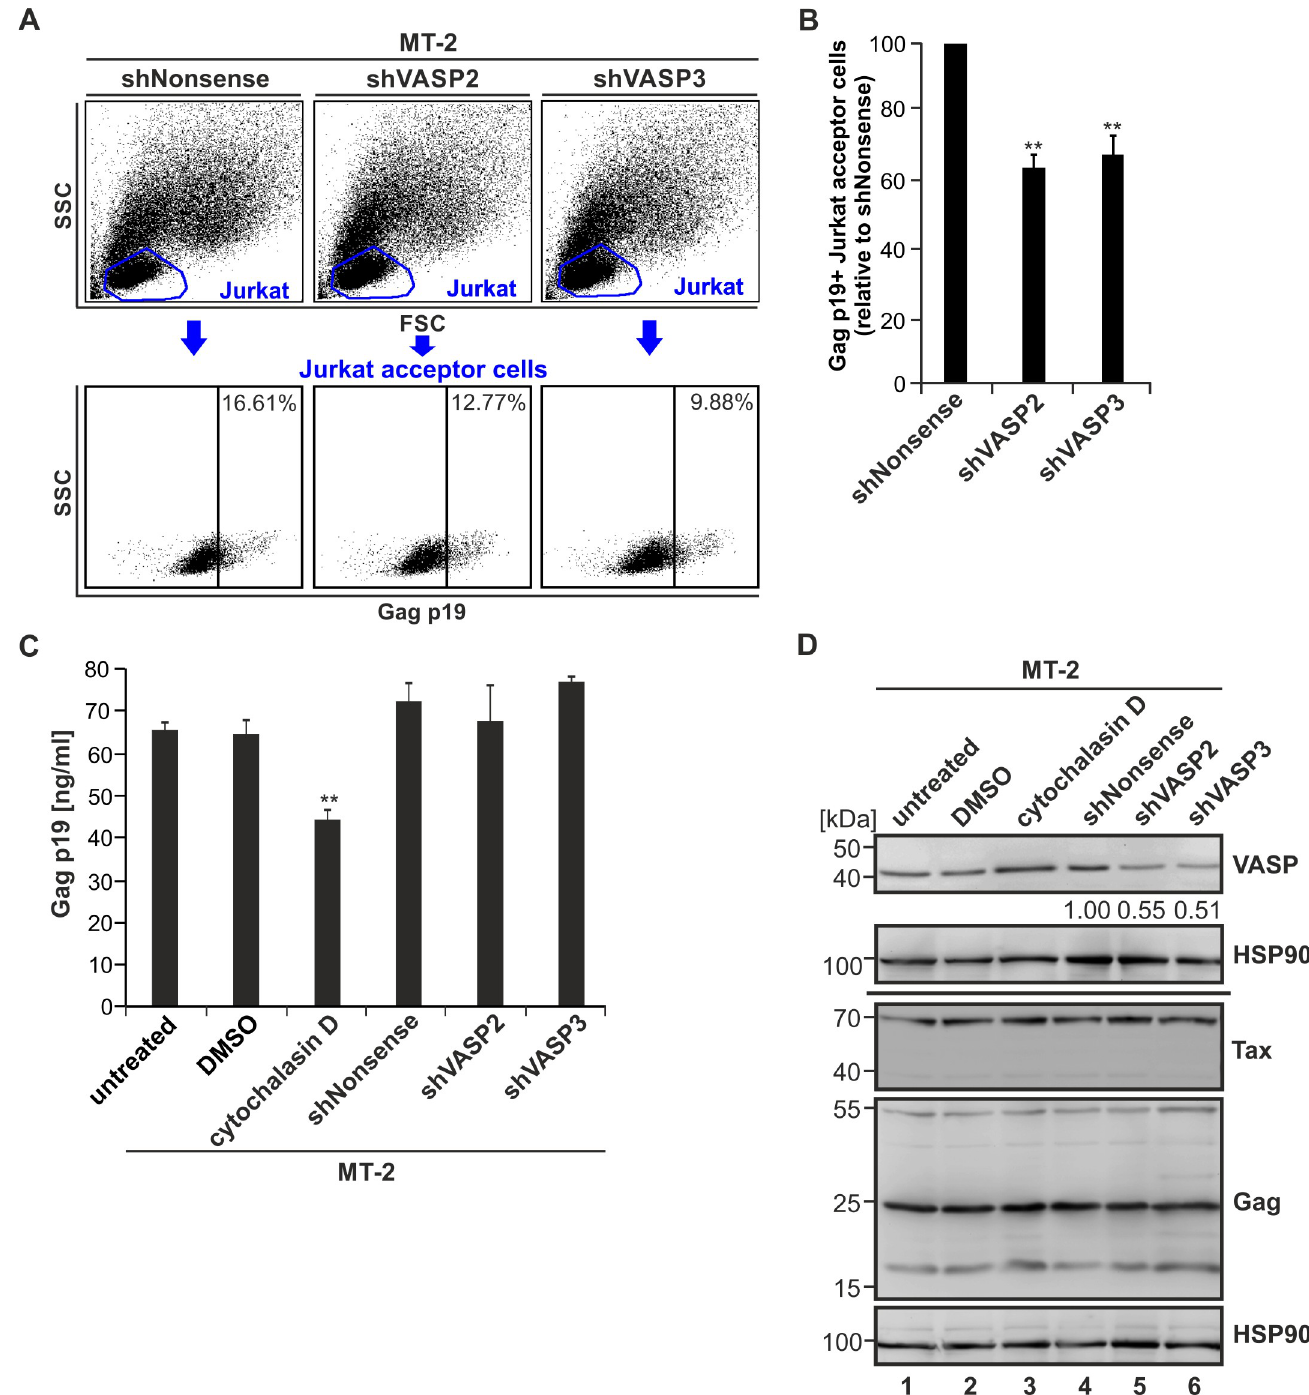
Fig 10. Repression of VASP impairs virus transmission to uninfected T-cells, but not Gag processing and virus release in chronically infected MT-2 cells. (A) Jurkat T-cells were co-cultured with stably transduced MT-2 cells (shNonsense, shVASP2, shVASP3) at a ratio of 1:1 for 1 h. The transfer of Gag p19 to Jurkat acceptor cells was measured by flow cytometry using the primary antibodies mouse anti-Gag p19 and the secondary antibodies anti-mouse Alexa Fluor 647. Upper part: Jurkat acceptor cells were gated by forward scatter (FSC) and side scatter (SSC) analysis; lower part: Gag p19-specific fluorescence (indicated by numbers) in Jurkat acceptor T-cells. (B) The amount of Gag p19 positive Jurkat acceptor cells normalized on the MT-2/shNonsense control cells of four independent experiments ± SE is depicted and was compared using Student’s t-test ( �� , p < 0.01). (C) The amount of Gag p19 protein in the supernatant of transduced MT-2 cell lines was assessed by Gag p19 ELISA. MT-2 cells treated with 5 μ M cytochalasin D, an inhibitor of actin-polymerization, in comparison to the DMSO solvent